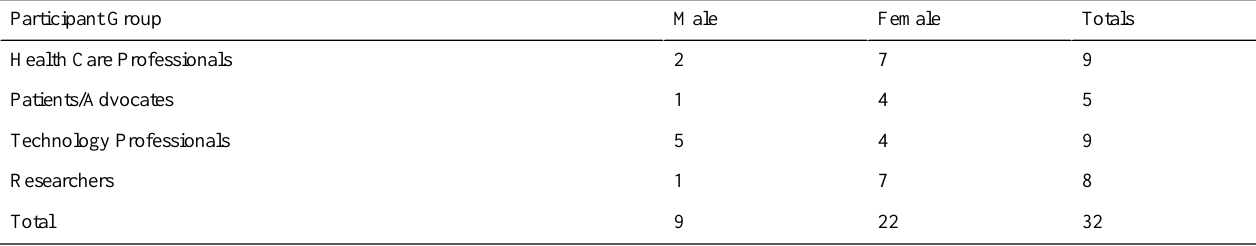
Table 1. Summary of